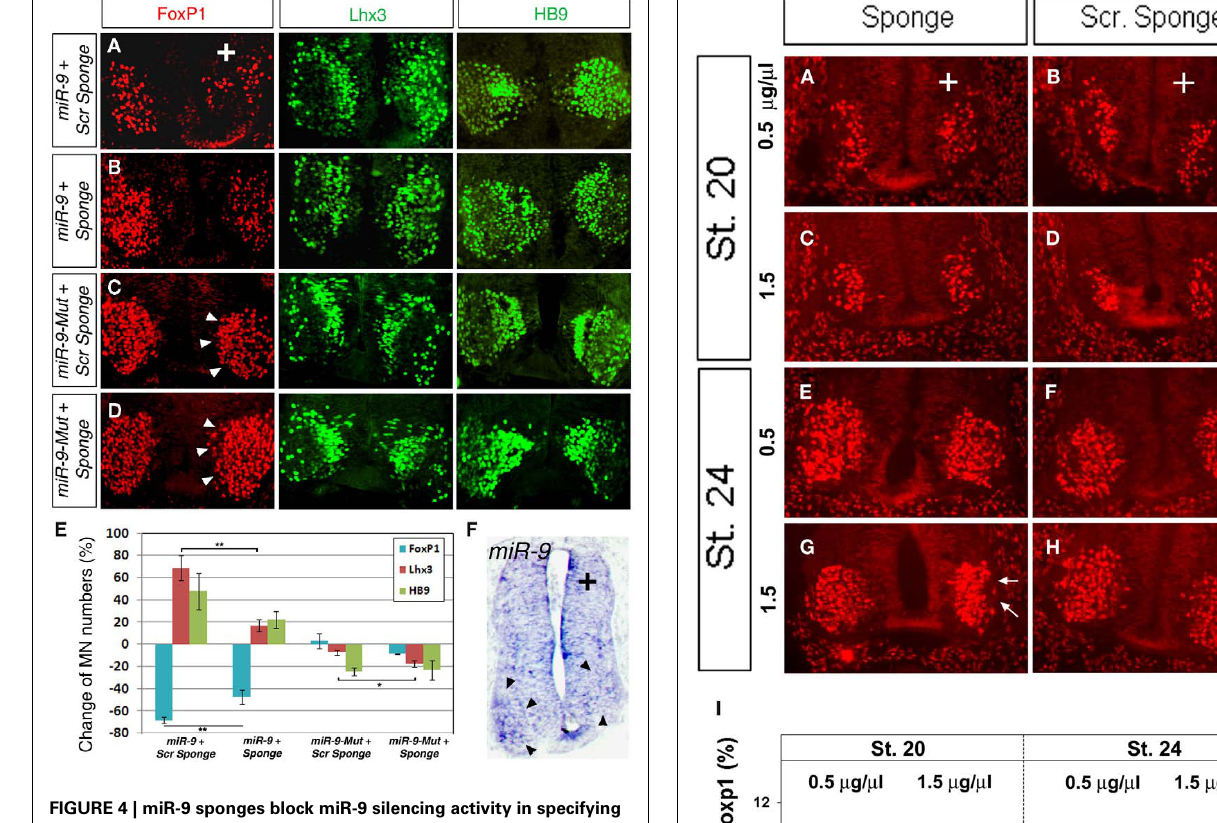
FIGURE 4 | miR-9 sponges block miR-9 silencing activity in specifying MN subtypes in developing spinal cord. (A) Co-electroporation of a scrambled (scr) sponge with miR-9 caused a decrease in numbers of FoxP1 + MNs and corresponding increase in Lhx3 + and HB9 + MNs. (B) Co-electroporation of a miR-9 sponge with miR-9 partially rescued the silencing effects of miR-9, as detected by increased numbers of FoxP1 + MNs and decreased numbers of Lhx3 + MNs. Numbers of HB9 + MNs appeared to be less increased. (C) Co-electroporation of a scrambled sponge with mutated-miR-9 (miR-9-Mut) caused no changes in MN numbers or FoxP1 intensity (arrowheads). (D) Co-electroporation of a miR-9 sponge with miR-9-Mut was able to block endogenous miR-9 and caused increased FoxP1 expression levels (arrowheads). (E) Quantification of MN numbers affected by miR-9 sponge or scrambled sponges when co-electroporated with miR-9 or miR-9-Mut. n > 5, FoxP1, ** p < 0.007; Lhx3 (with miR-9), ** p < 0.006; Lhx3 (with miR-9-Mut), * p < 0.04. (F) Electroporation of miR-9 sponge alone. In situ hybridization for miR-9